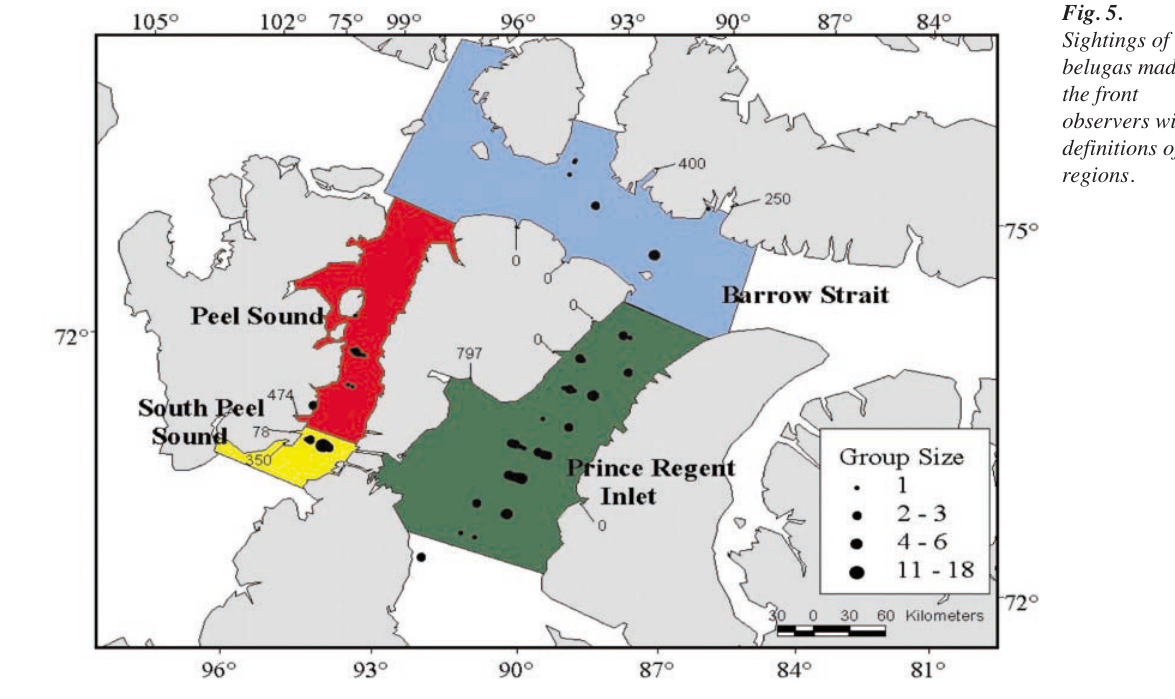
Fig. 5. Sightings of belugas made by the front observers with definitions of regions.